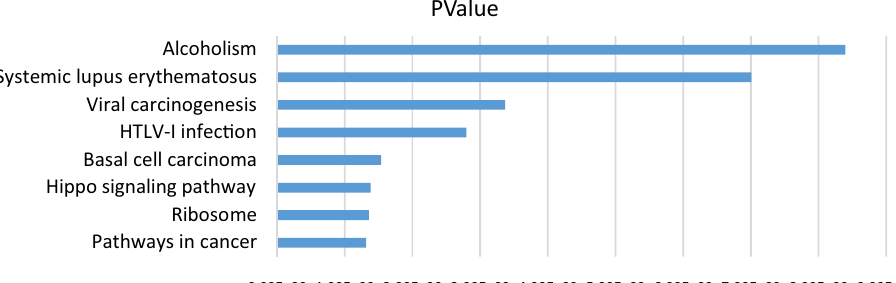
Figure 6. KEGG pathway analysis of 160 differentially expressed (DE) mRNAs.